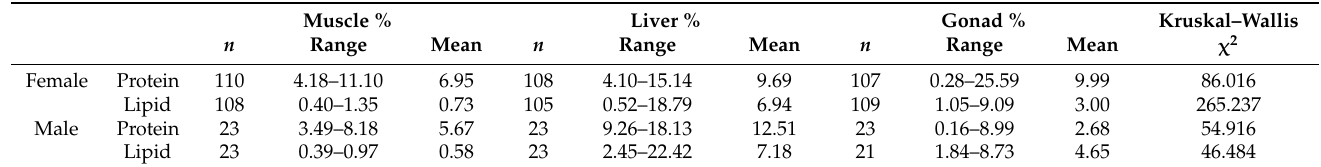
Table 4. Percentage of lipids and proteins in each tissue of Gobio lozanoi. All p -values in Kruskal–Wallis test are significant (<0.001).